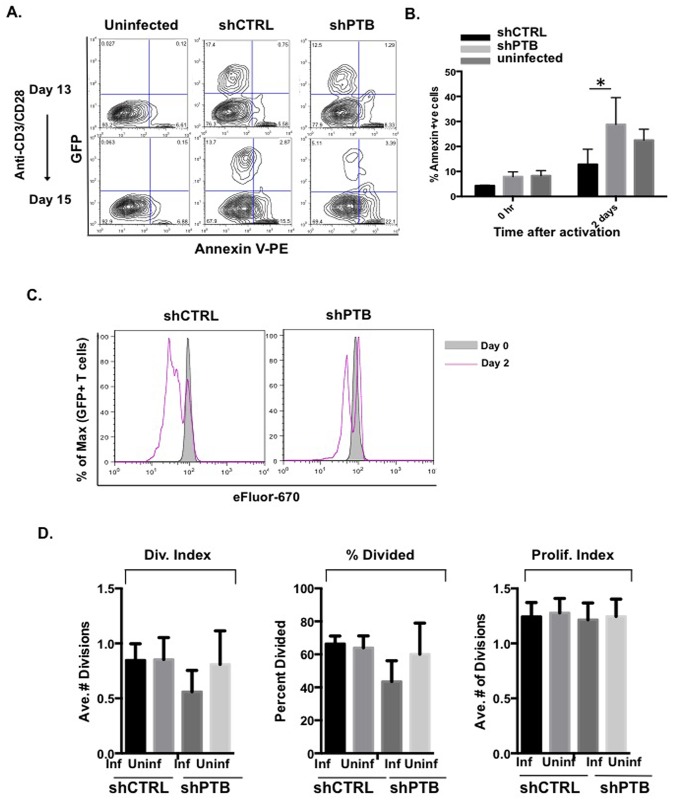
Reduced PTBP1 inhibits CD4 T cell Proliferation but not viability.(A) Analysis of cell viability in pLV-shCTRL or pLV-shPTB infected cells was carried out by staining 2×105 cells with Annexin-V and analyzing GFPpos Annexin-Vpos cells prior to and after 48 h activation with anti-CD3 and anti-CD28 antibodies. Numbers shown are the percentage of PE-Anexin-Vpos cells in the total (GFPpos and GFPneg) population and comparisons were made between the pLV-shCTRL and pLV-shPTB infected cells as well as the infected and uninfected cells in the same population. (B) Compiled data from three independent experiments showing the extent of cell death in uninfected and pLV-shCTRL- and pLV-shPTB-infected T cells before and 48 h after stimulation with anti-CD3 and anti-CD28 beads. (C) 5 X 106 pLV-shCTRL- and pLV-shPTB-infected T cells were incubated at day13 post-infection with 10 μM cell proliferation dye eFluor670 concurrently with the addition of anti-CD3/anti-CD28 conjugated beads for activation. Uninfected (GFPneg) and infected (GFPpos) populations were analyzed by flow cytometry at day 0 and day 2. (D) Division Index, Percent Divided and Proliferation Index were determined using FloJo software from three independent experiments (mean values (+/- SEM) with a *p≤0.05).